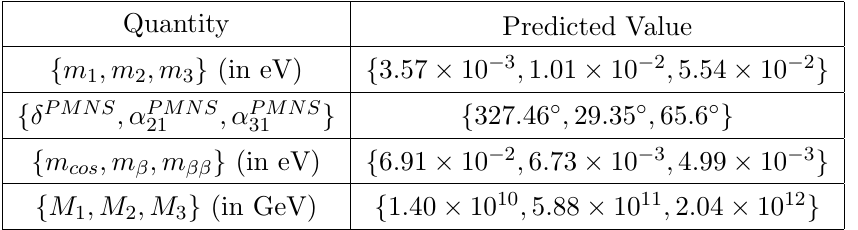
Table 6 . Predictions corresponding to the best (cid:12)t values presented in table 5 for type-I dominance seesaw scenario. m i are the light neutrino masses, M i are the right handed neutrino masses, (cid:11) 21 ; 31 are the Majorana phases following the PDG parametrization, m cos = P the e(cid:11)ective mass parameter for beta-decay and m (cid:12)(cid:12) = for neutrinoless double beta